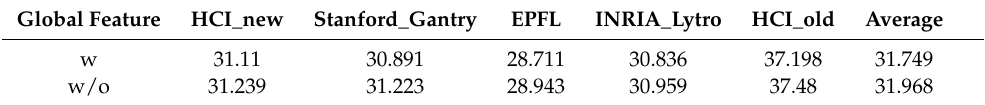
Table 2. Ablation study of Global Feature in the proposed model. We compare the performance of the model with (w) or without (w/o) Global Feature on different test datasets and report the PSNR results.